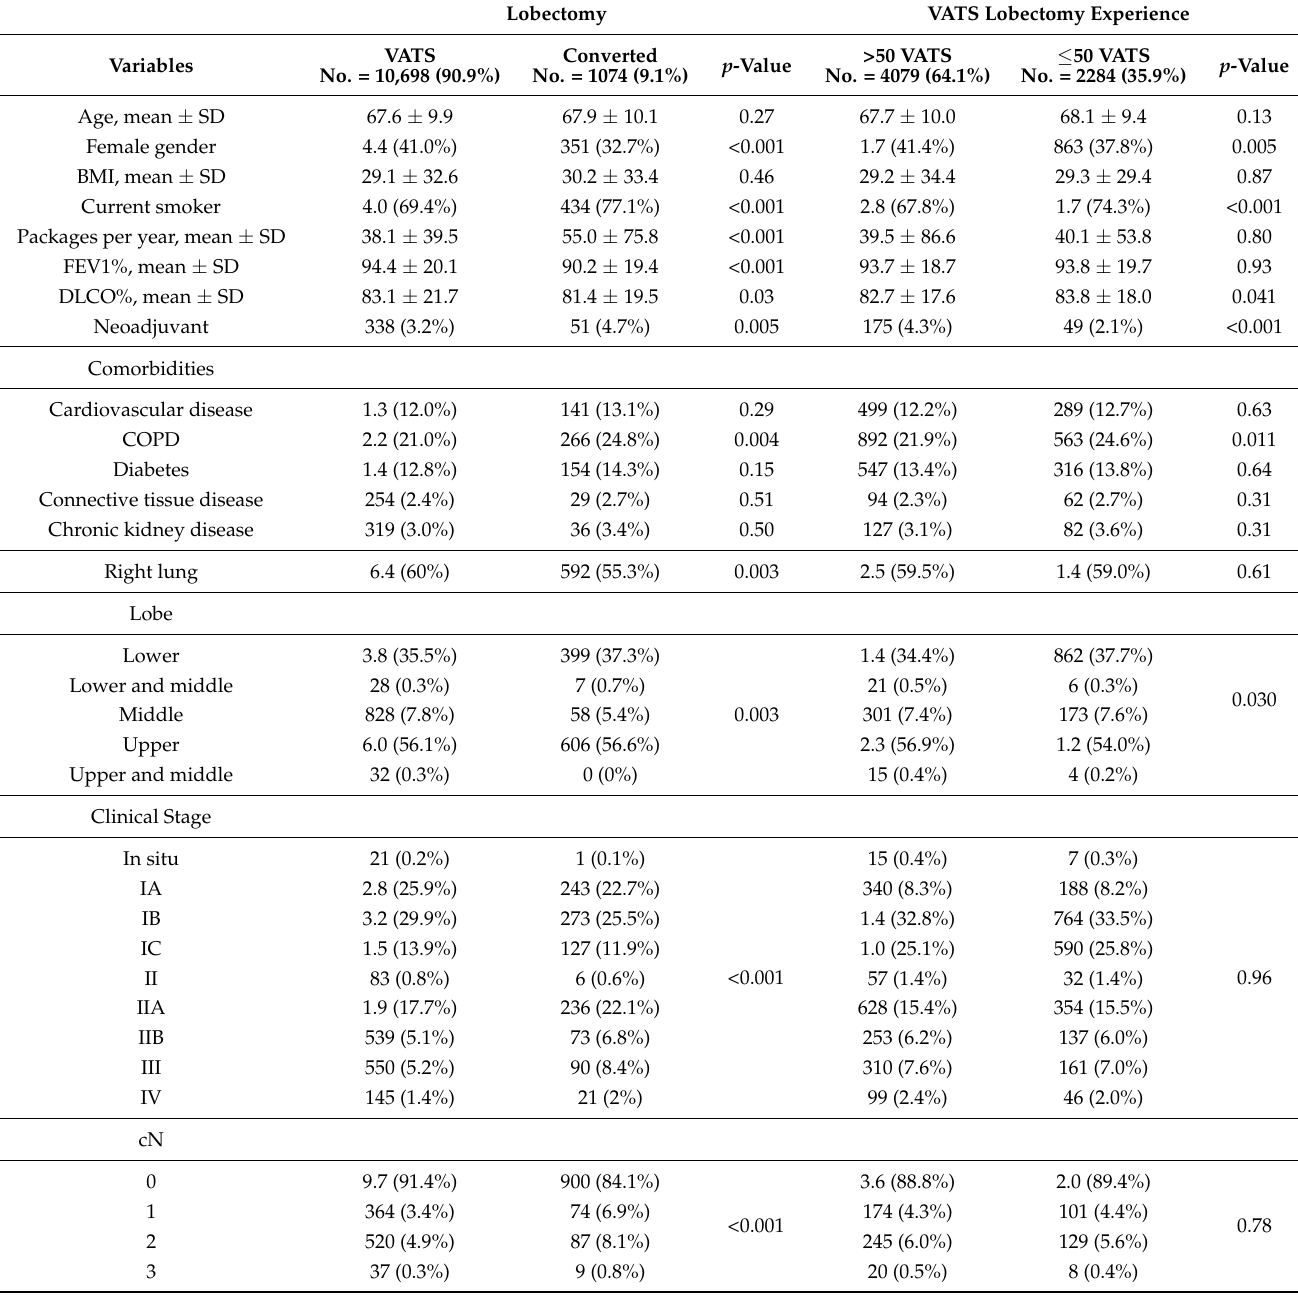
Table 2. Comparisons by lobectomy groups (VATS versus converted to thoracotomy) and VATS lobectomy experience of the first operator (>50 VATS versus ≤ 50 VATS lobectomies). Values are expressed as numbers (percentages) as otherwise defined. BMI = body mass index; COPD = chronic obstructive pulmonary disease; DLCO = diffusing capacity of the Lung for Carbon Monoxide; FEV1 = forced expiratory volume in 1 s; SD = standard